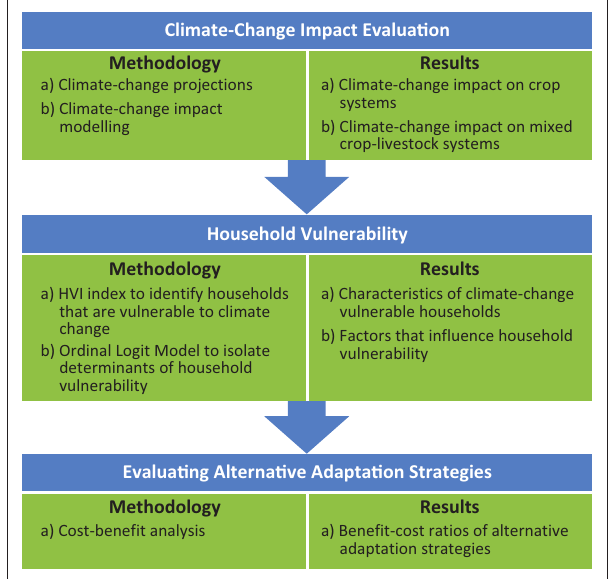
FIGURE 1: The analytical